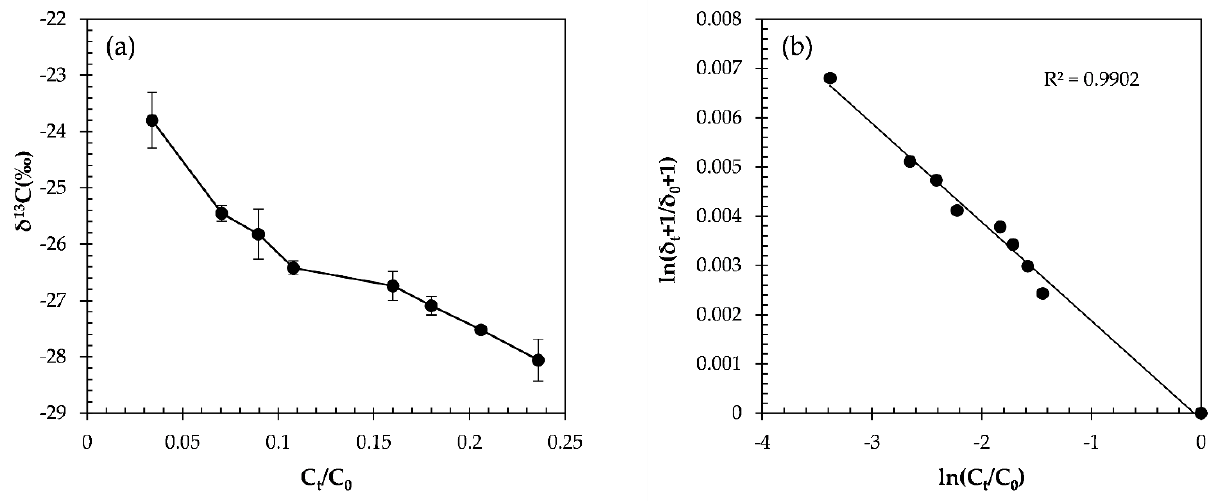
Figure 3. The α -HCH transformation by CaO 2 : ( a ) remaining fraction and carbon isotope ratios for oxidation by CaO 2 ; ( b ) double logarithmic plot according to the Rayleigh equation.